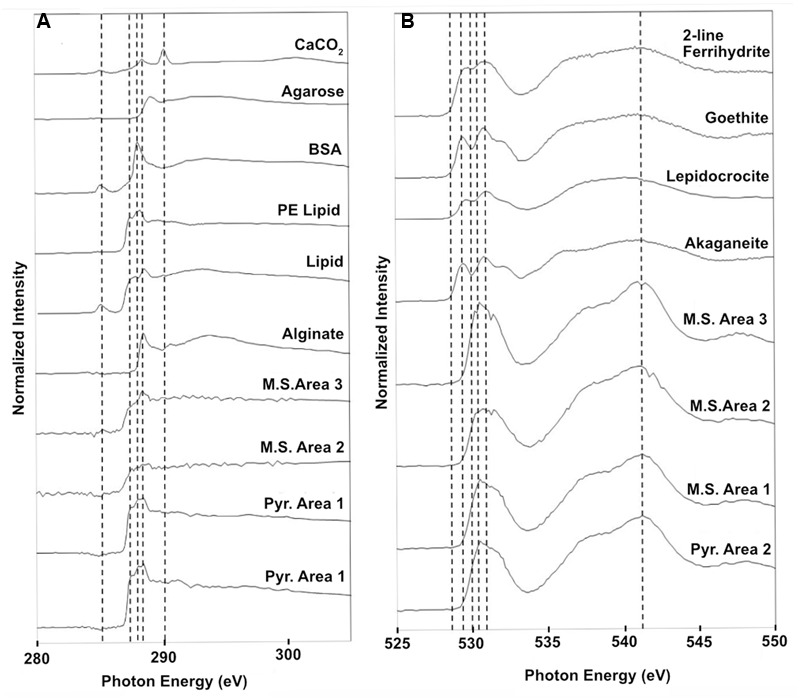
Normalized STXM three-dimensional stacks of particles on the NE-FLOCS substrates; (A) Carbon 1s XANES spectra found on both pyrite and mild steel along with reference spectra; (B) Oxygen 1s XANES spectra for both pyrite and mild steel along with reference spectra for 2-line ferrihydrite, goethite, lepidocrocite, and akaganeite. Vertical dashed lines are for reference in aligning spectral features across samples.